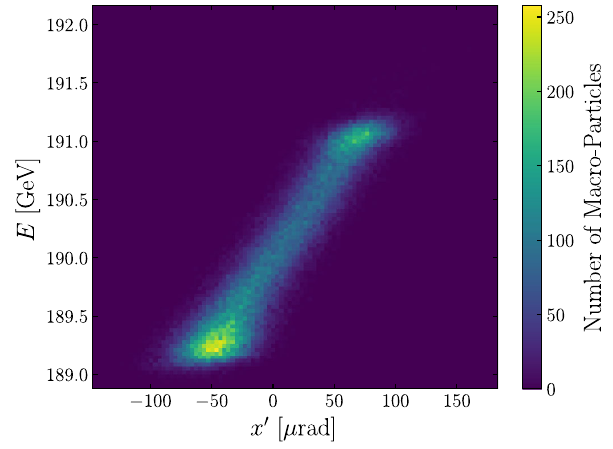
FIG. 5. Energy E vs horizontal angle x 0 of the IP beam distribution. This beam was tracked through a perfect beamline.